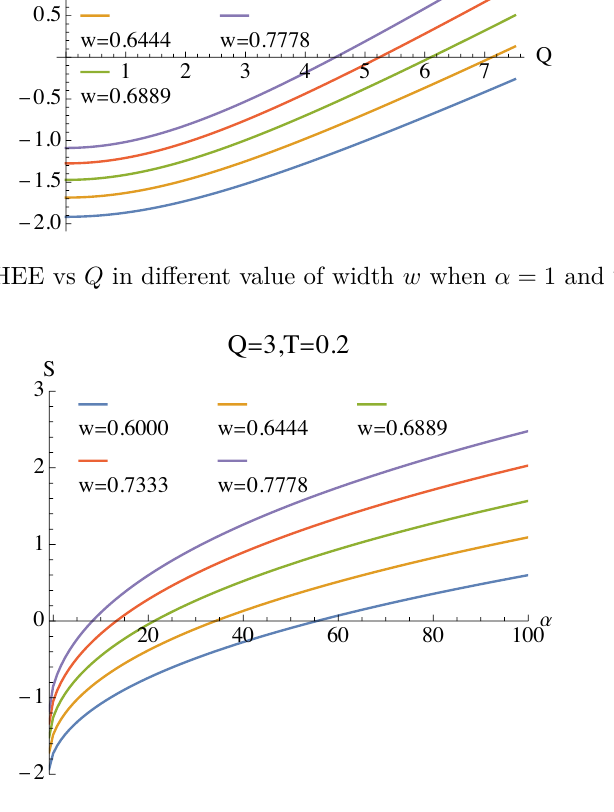
Figure 6 . HEE vs α in different value of width w when Q = 3 and T = 0 . 2 . The HEE increases with the increase of α